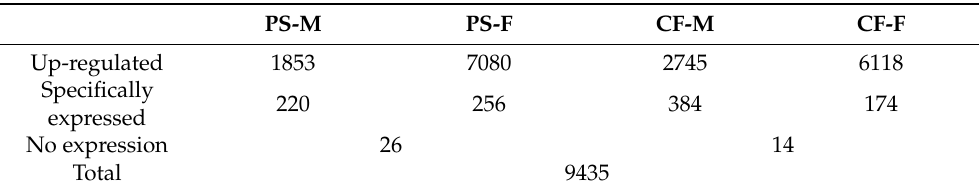
Table 2. The summary of new unigenes with >98% identity between two libraries of Portunus sanguinolentus and Charybdis feriatus .